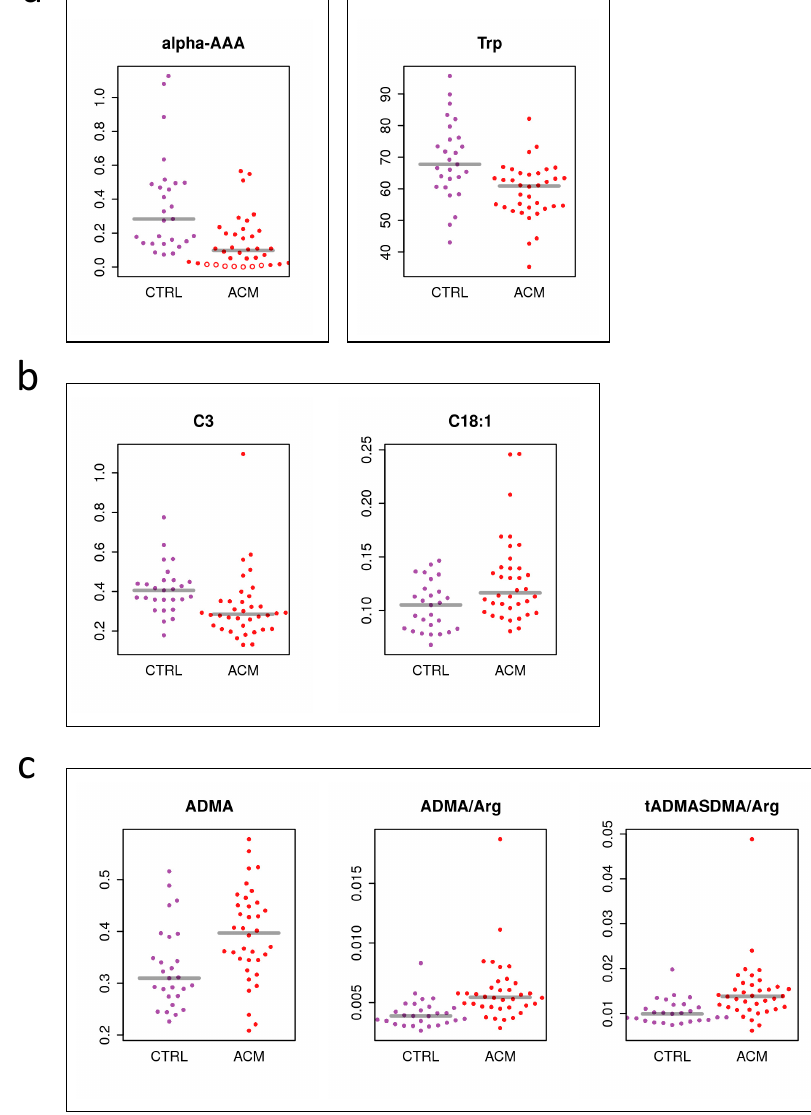
Figure 4. Individual analyte concentrations (adjusted for sex and batch) for significant metabolites ( a , b ) and metabolite ratios ( c ). CTRL (purple dots), ACM (red dots). Open circles indicate imputed values for original measurements being below the system’s detection limit. Alpha-AAA: alpha-aminoadipic acid; Trp: tryptophan; C3: carnitine C3; Arg: arginine; ADMA: asymmetric dime- thylarginine.